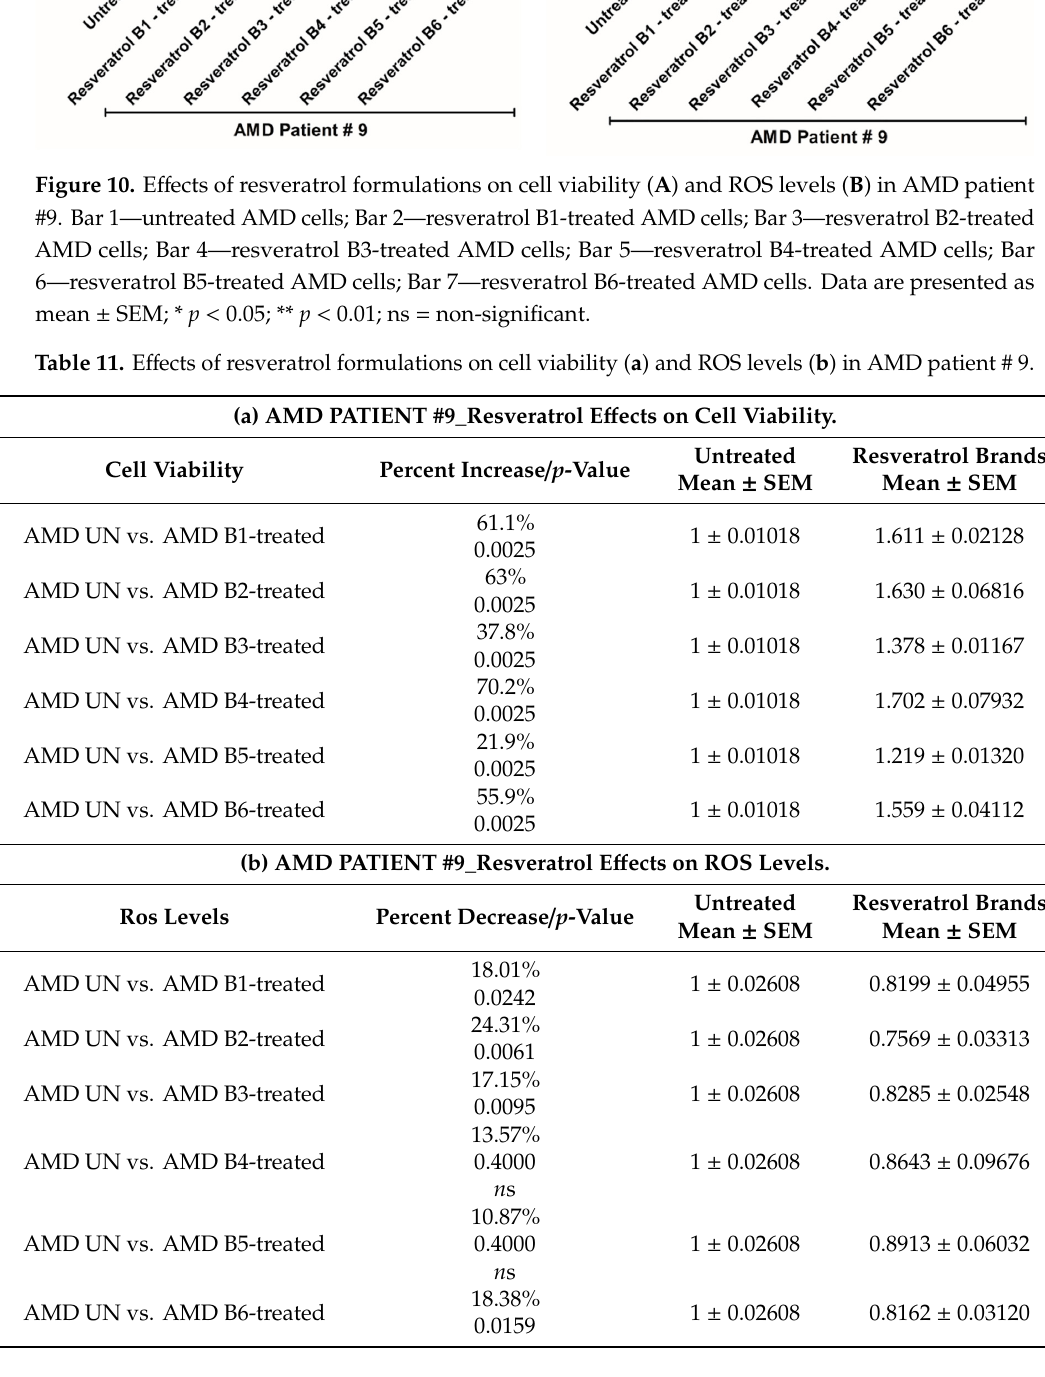
Figure 10. Effects of resveratrol formulations on cell viability ( A ) and ROS levels ( B ) in AMD patient